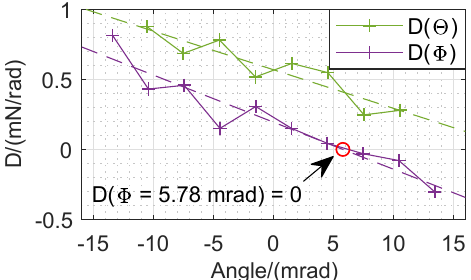
Figure 15. Correlation between tilt angle and tilt sensitivity of the weighing